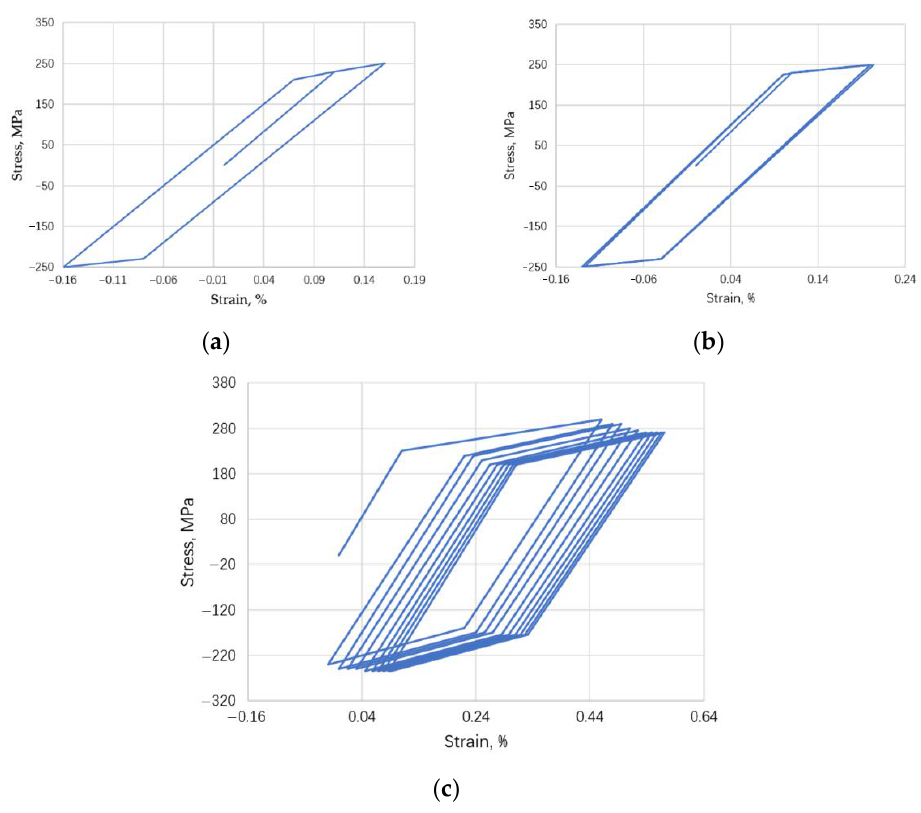
Figure 6. Stress-strain curves of 409 nodes in notched sheet simulated by Chaboche model under different ratios. ( a ) Ratio = −1; ( b ) ratio = −0.8; ( c ) ratio = −0.5.